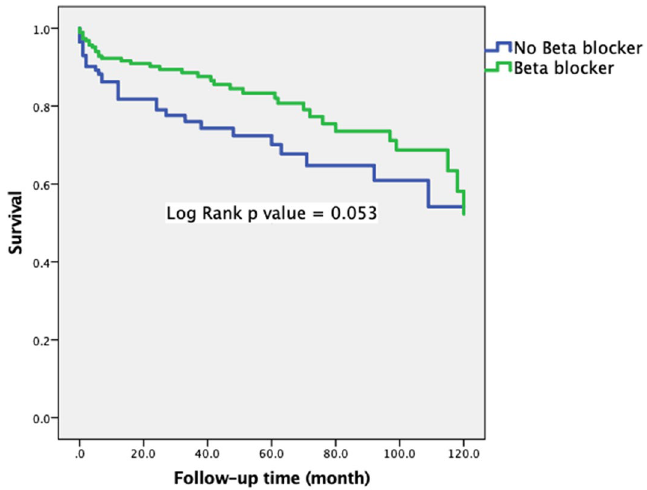
Figure 3. Kaplan–Meier curve within ischemic heart disease according beta blocker use.